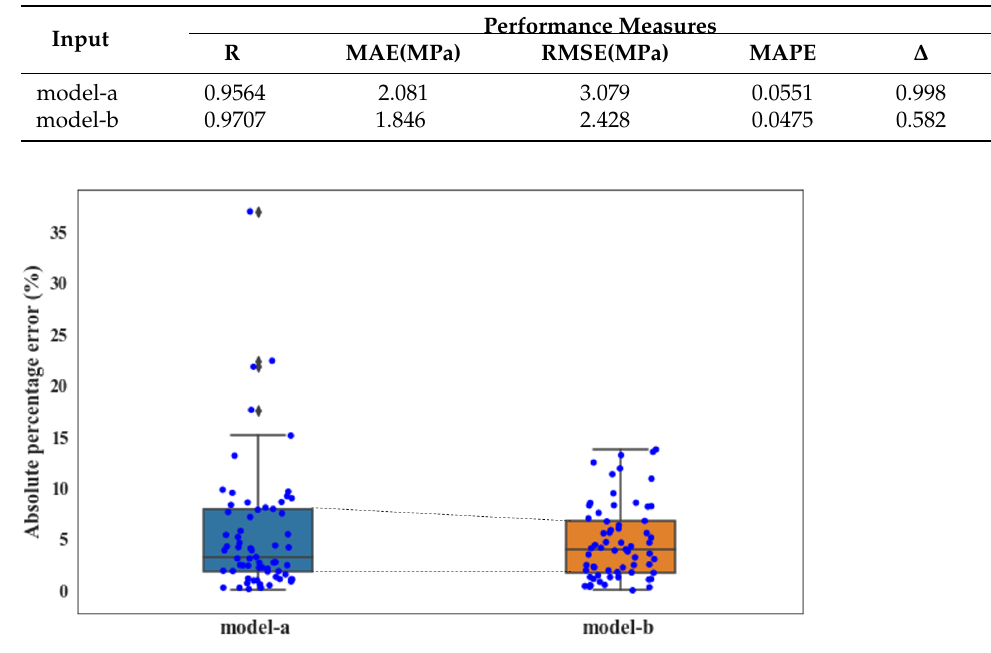
Figure 5. Comparison between the recorded actual concrete CS and the predicted value from: ( a ) concrete ingredient modeling, and ( b ) comprehensive 4M1E modeling. Table 4. Predictive performance comparison of model-a and model-b.